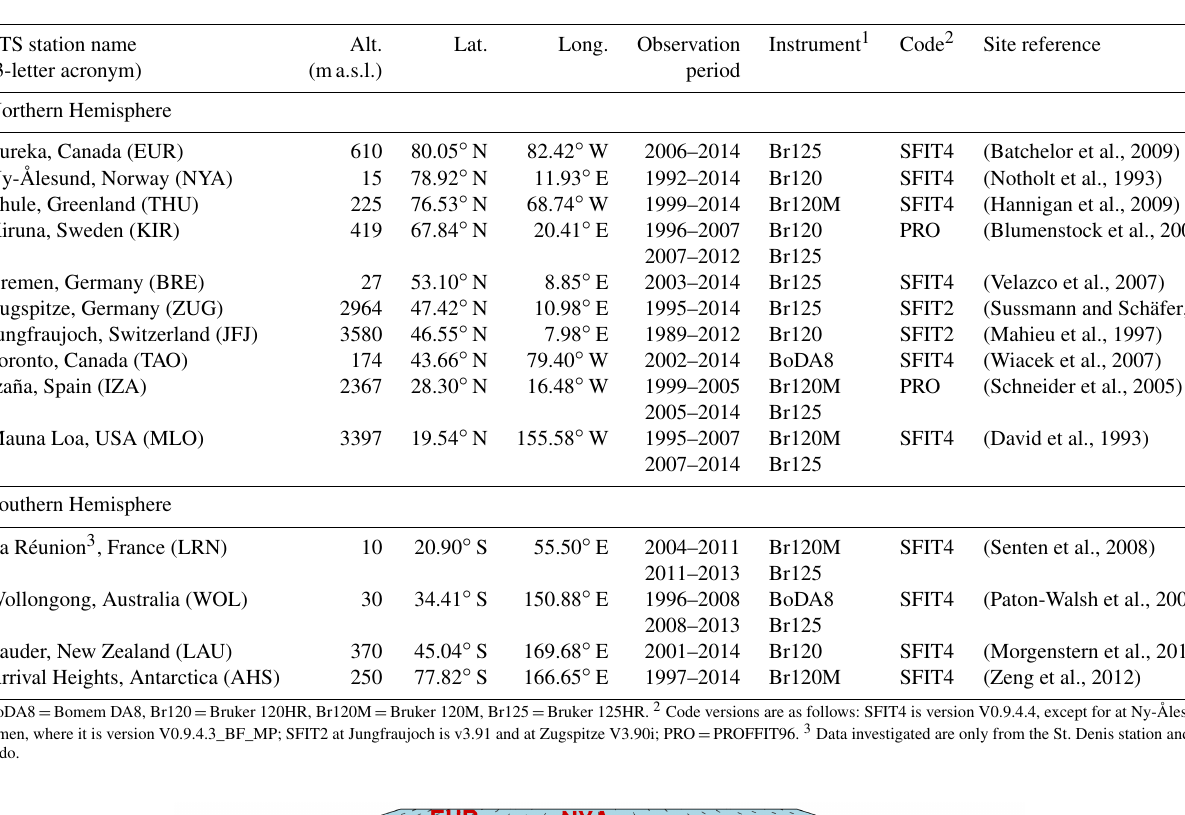
Table 1. Information about the 14 NDACC ground-based remote-sensing FTS sites. Locations are ordered by latitude.